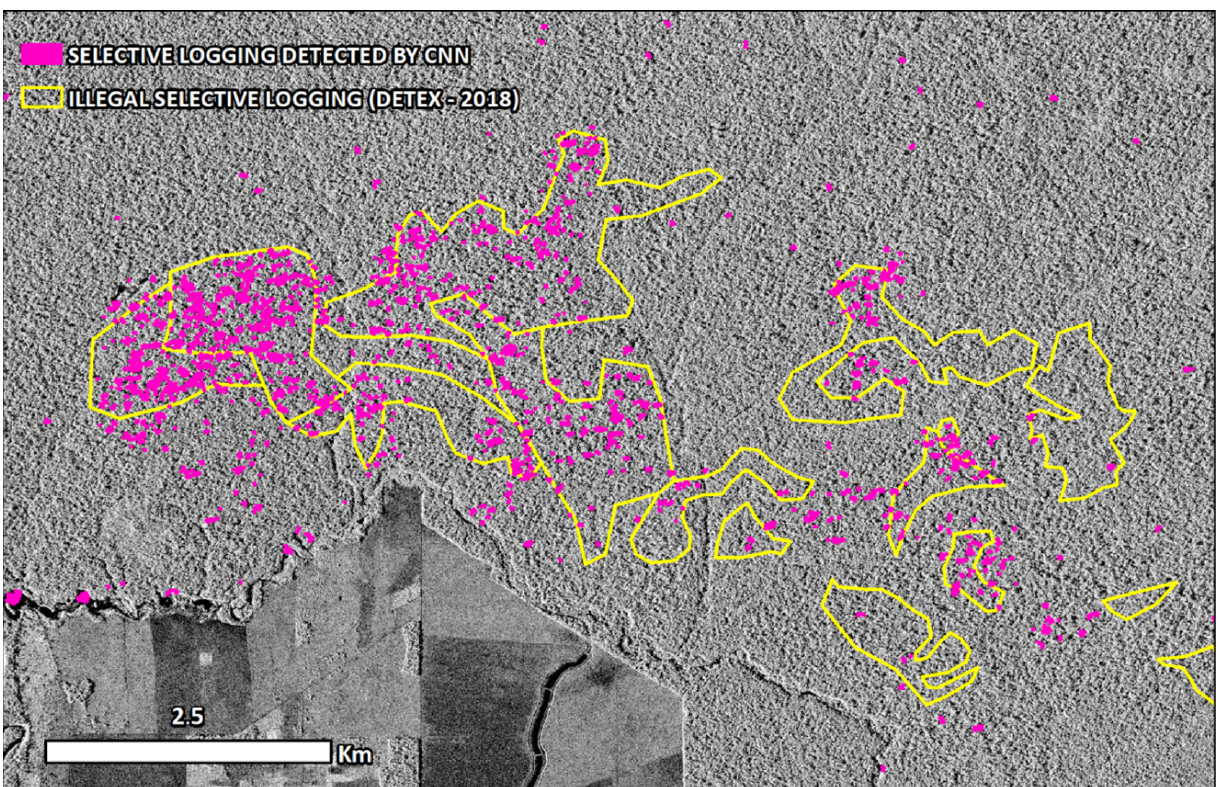
Figure 6. Comparison between selective logging detected by CNN (magenta) and by DETEX (yel- low).